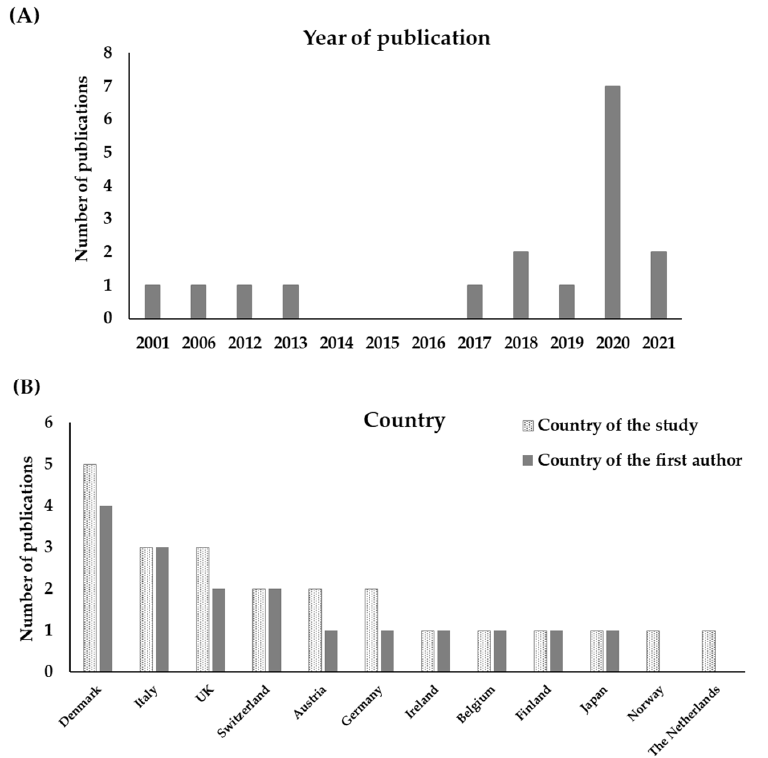
Figure 1. Number of publications by year of publication ( A ), country of the location of the study and first author affiliation ( B ). One publication had more than one country as location of the study. Table 3. Number and percentage of publications by name of the peer-reviewed journal.